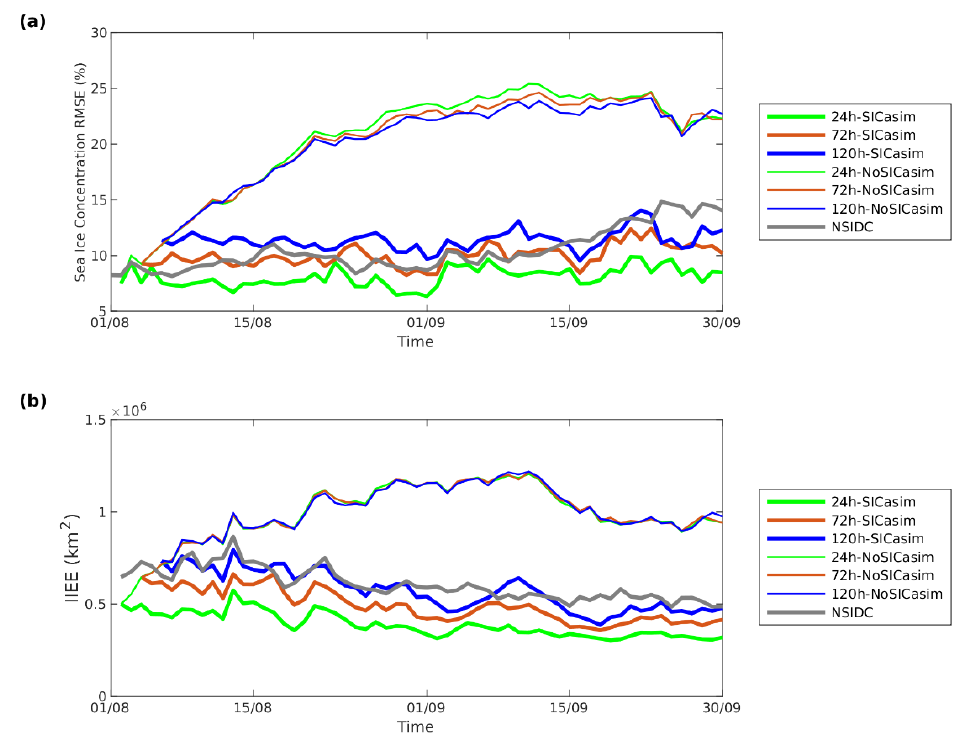
Figure 7. Sea ice concentration RMSE ( a ) and IIEE ( b ) time series of the FIO-COM10 forecast from 1 August to 30 September 2021. The forecasts with and without sea ice concentration assimilation are shown in thick and thin lines, respectively. The RMSE and IIEE of NSIDC with respect to the OSISAF observation are shown in thick gray lines.